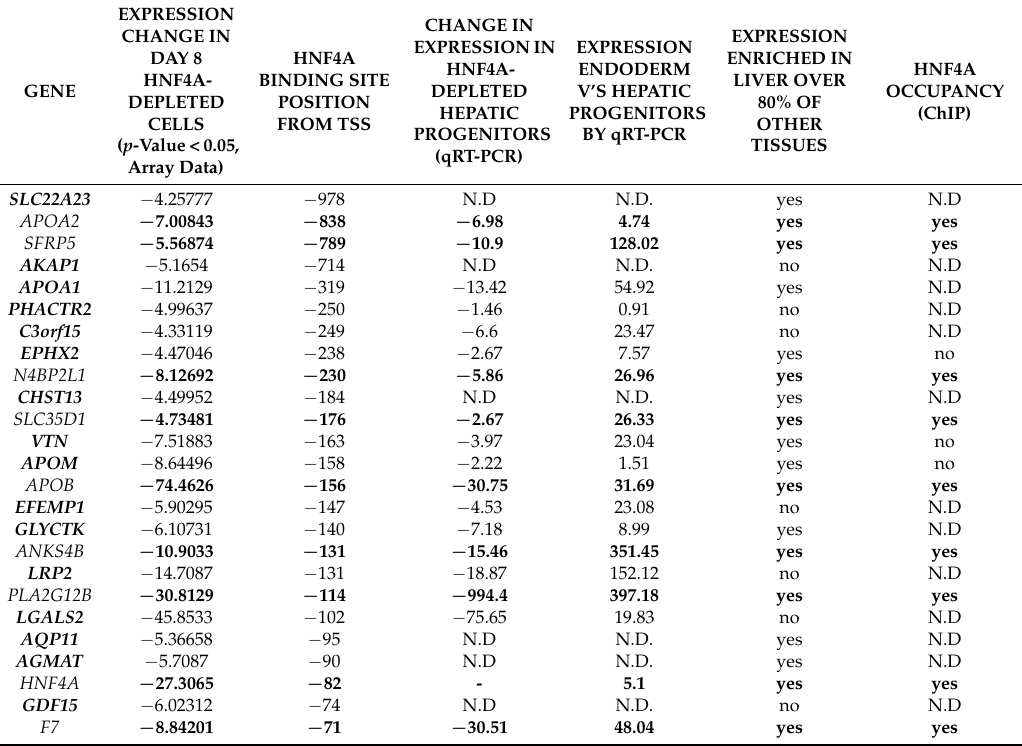
Table 1. Direct targets of HNF4A expressed during the endoderm to hepatic transition. N.D: not determined.